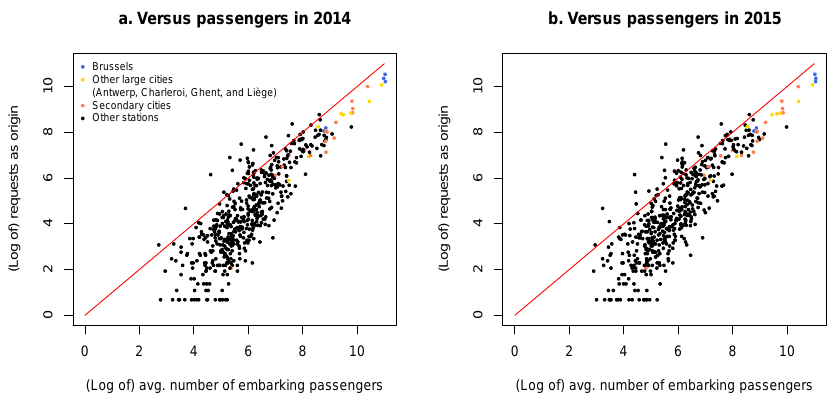
Figure 3. iRail requests versus observed travel demand. ( a ) Versus passengers in 2014; ( b ) Versus passengers in